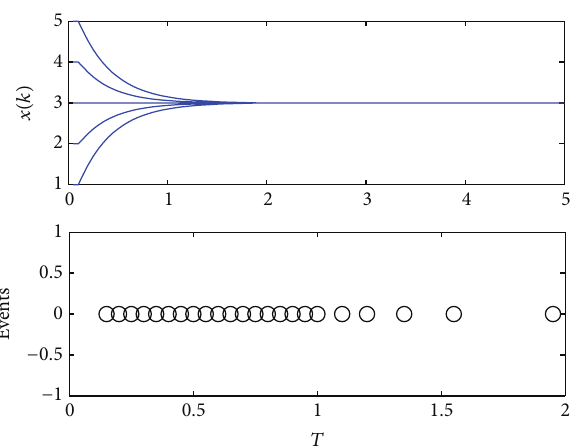
Figure 1: Nominal communication topology based on the second- order neighbors’ information.